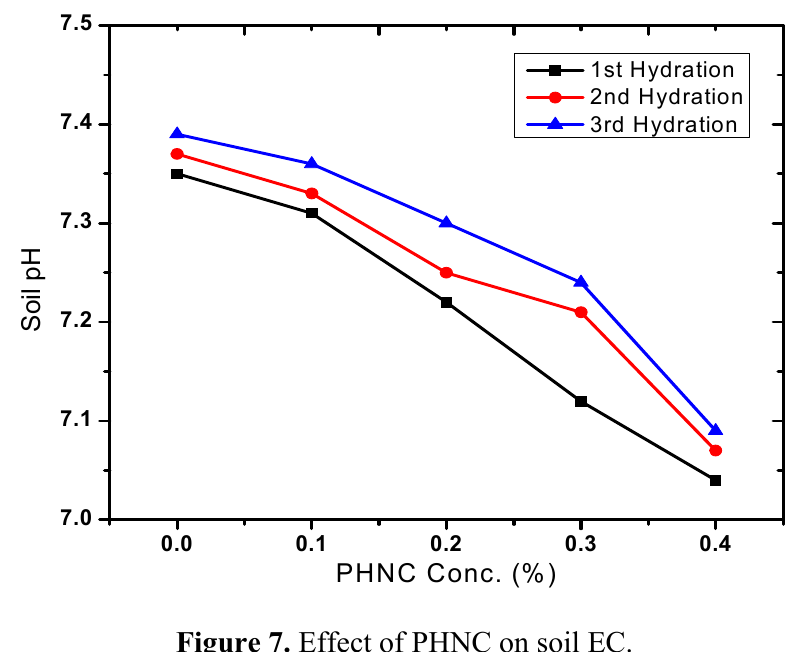
Figure 6. Effect of PHNC on soil pH.